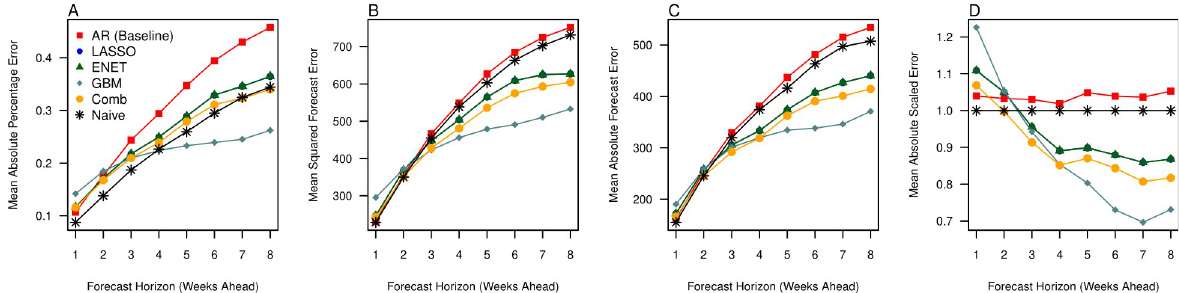
Fig 2. Forecast assessment statistics across the forecast dataset, comparing observations in the period of 2018–2022 to the 6 forecasting models, which includes the baseline autoregressive (AR) model, the Least Absolute Shrinkage and Selection Operator (LASSO), the elastic net (ENET), gradient boosted machines (GBM), a simple average of all forecasts (Comb) and the na ï ve forecast using (A) mean absolute percentage forecast error, (B) root mean squared forecast error, (C) mean absolute forecast error and (D) mean absolute scaled error across the forecast horizons of 1–8 weeks